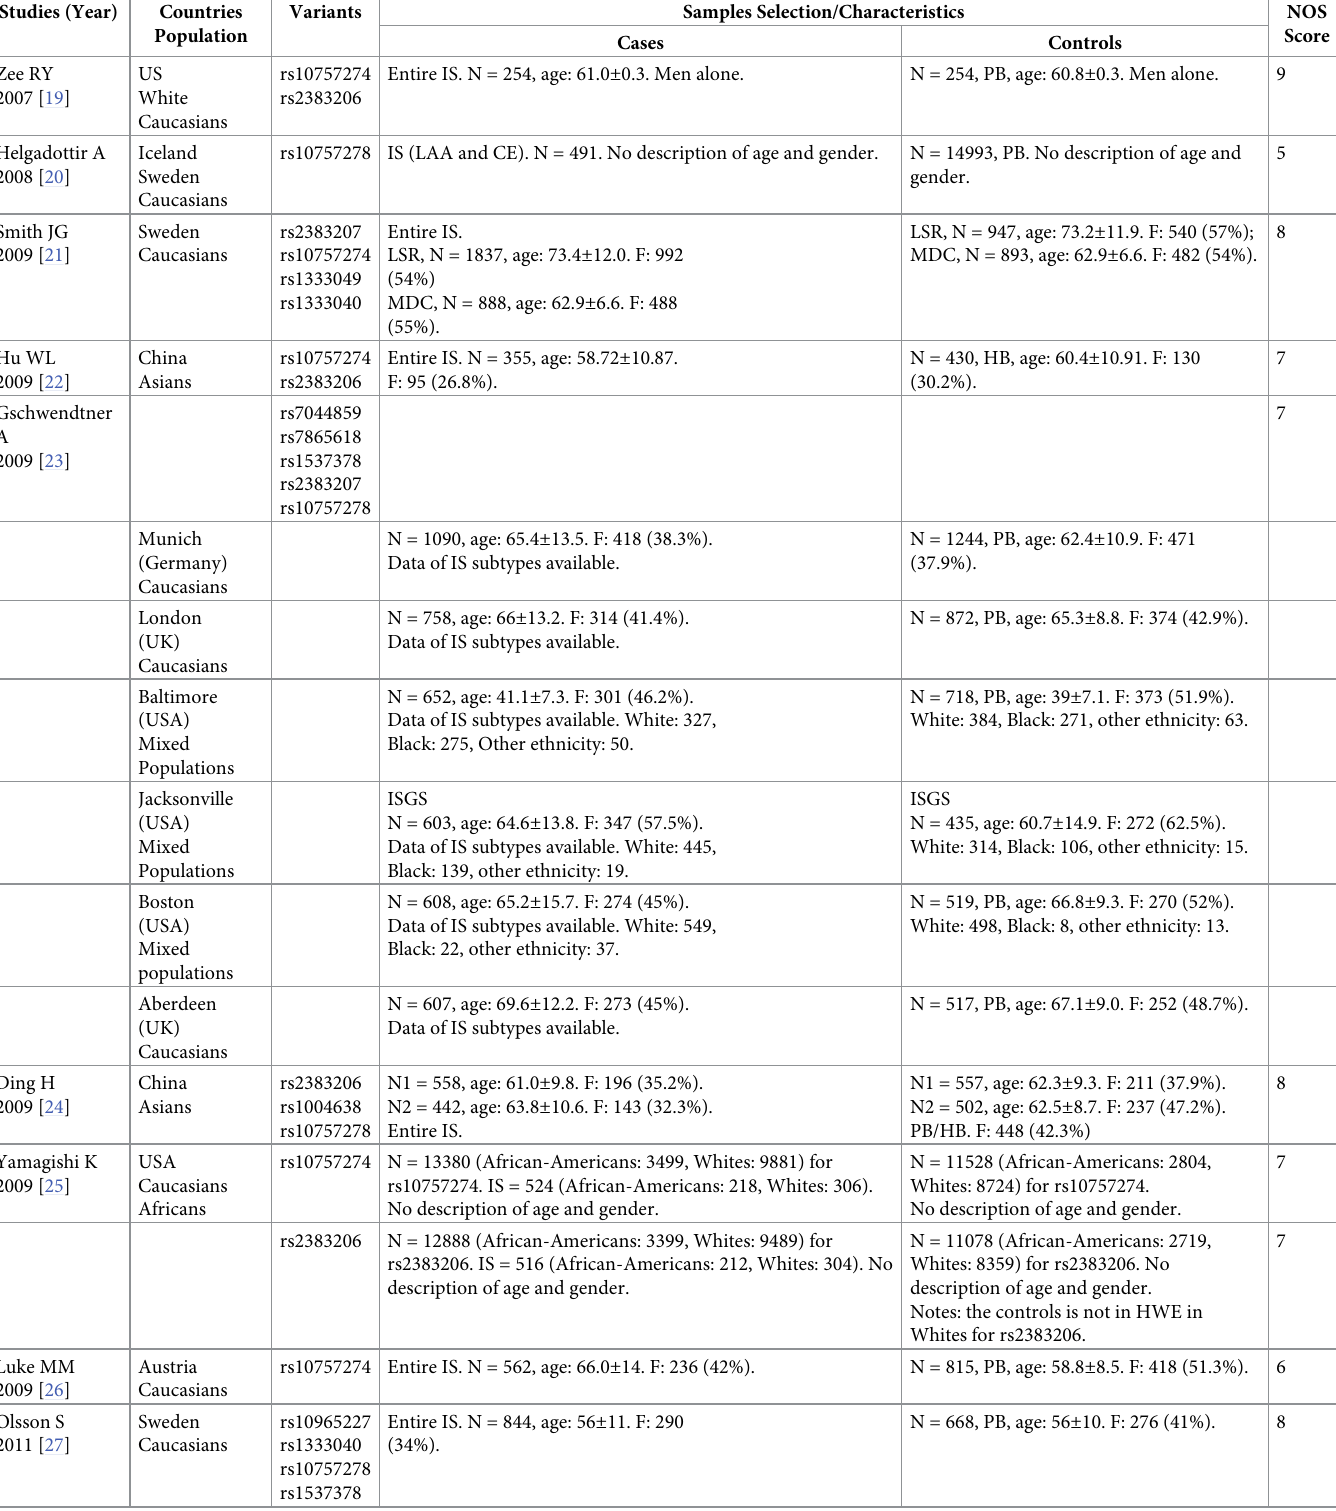
Table 1. Characteristics of included studies and ANRIL polymorphisms for